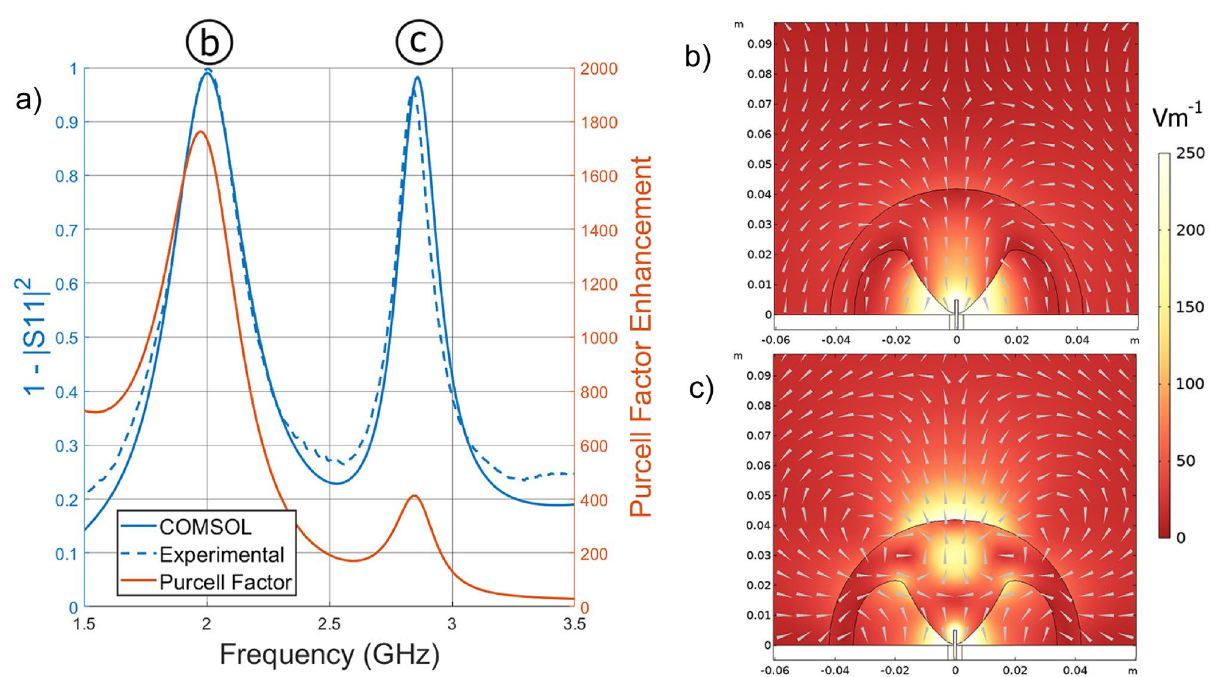
Figure 3. ( a ) The left y-axis displays the ratio of input power to transmitted power as a function of frequency predicted in numerical modelling and observed in experiment, and the right y-axis shows the numerically modelled Purcell Factor enhancement of the system relative to a freely radiating dipole, between 1.5 and 3.5 GHz. ( b ) and ( c ) the normalised electric field in the x-z plane with arrows indicating direction of field flow at 2.00 GHz and 2.86 GHz respectively, simulated via numerical